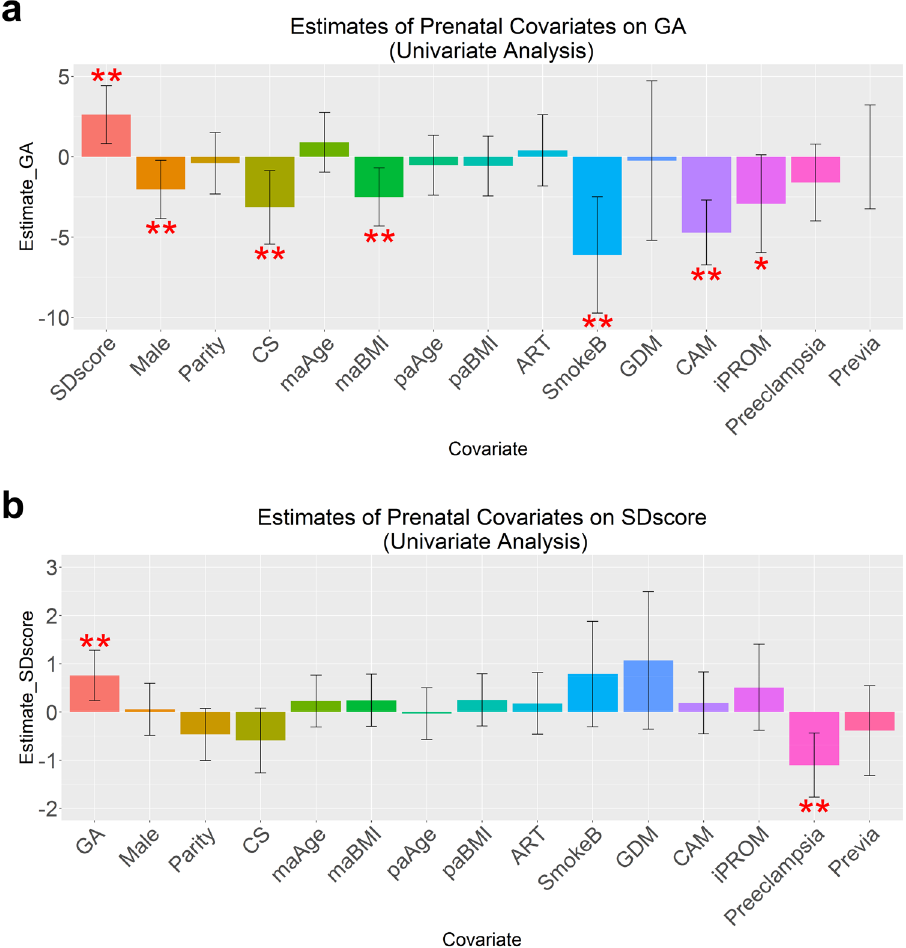
Figure 1. Association of prenatal covariates with gestational age and/or birth weight SD scores (n = 110, cord blood samples). ( a ) Association of prenatal covariates with gestational age (GA). Red asterisks with each covariate represent p -values for association between predictor (GA or birth weight SD score) and prenatal covariate (double red asterisks = p value < 0.05 (univariate linear regression analysis); single red asterisk = p value of 0.060 (suggestive)). Regression coefficients (Estimates) and p values are reported as a week’s change in GA for two standard deviation increases in continuous prenatal variables, or for comparing the two categories of binary prenatal variables. Error bars indicate 95% confidence interval of effect size. ( b ) Associations of prenatal covariates with birth weight SD scores. Estimates are reported as changes in birth weight SD scores for two standard deviation increases in continuous prenatal variables, or for comparing the two categories of binary prenatal variables. Abbreviations & which covariate is continuous or binary: [Continuous covariates] GA